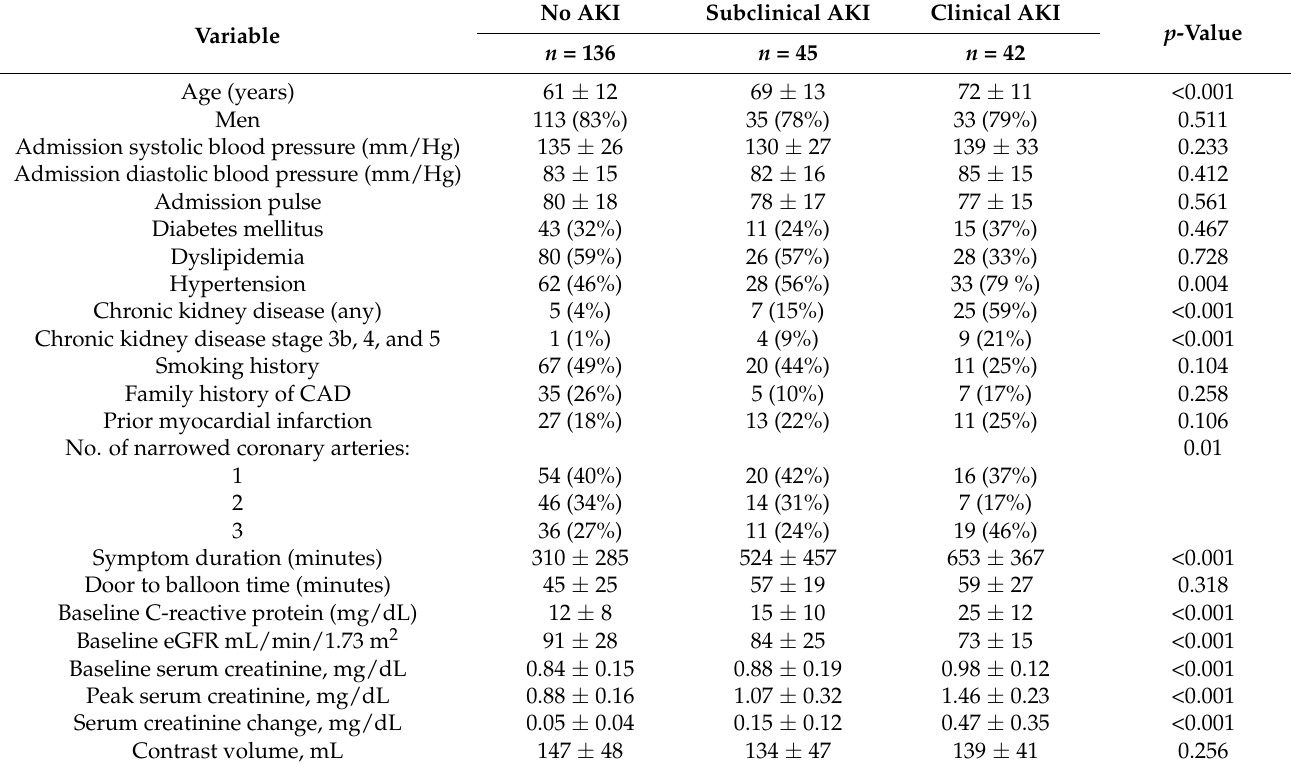
Table 1. Baseline characteristics of 223 STEMI patients according to AKI state occurrence.